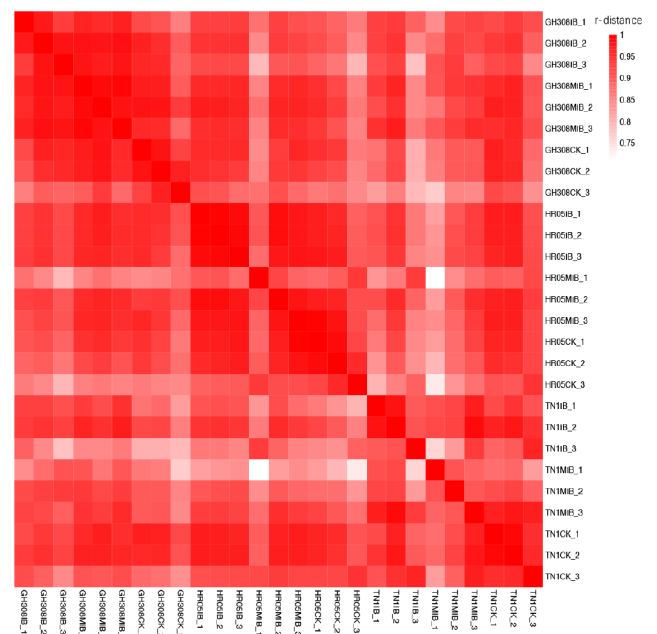
Figure 2. Correlation heat map of all samples. The dark red color indicates a high level of correlation between samples, while the white color indicates a low ratio of correlation.